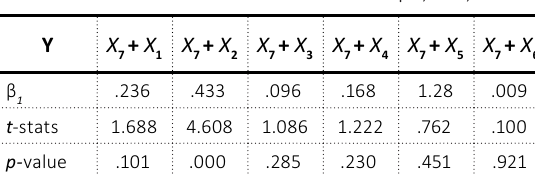
Table 2. Summary of results based on step 2: